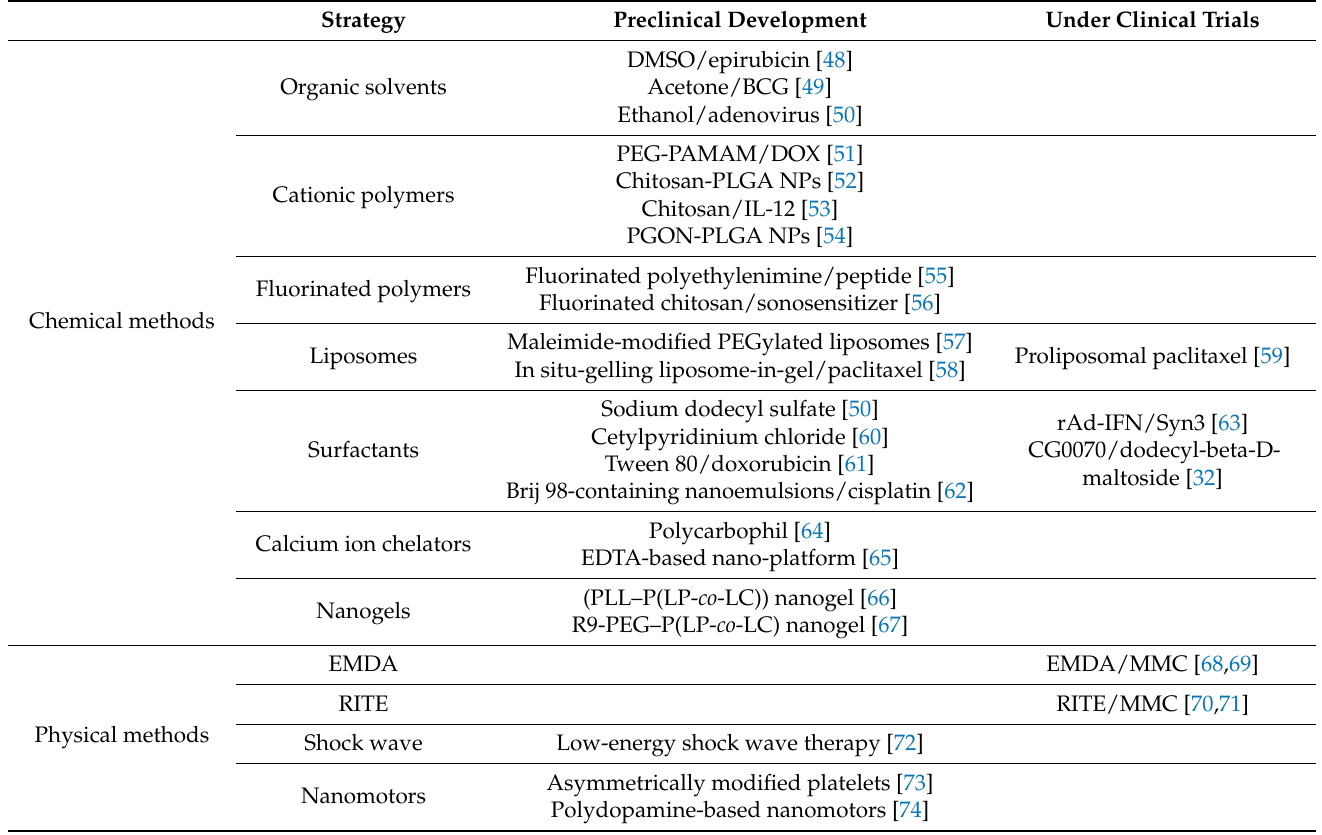
Figure 2. Chemical and physical strategies to get drugs across bladder penetrating barriers for improving bladder cancer therapy. Table 1. The development stage of each strategy to get drugs across bladder penetrating barriers for improving bladder cancer